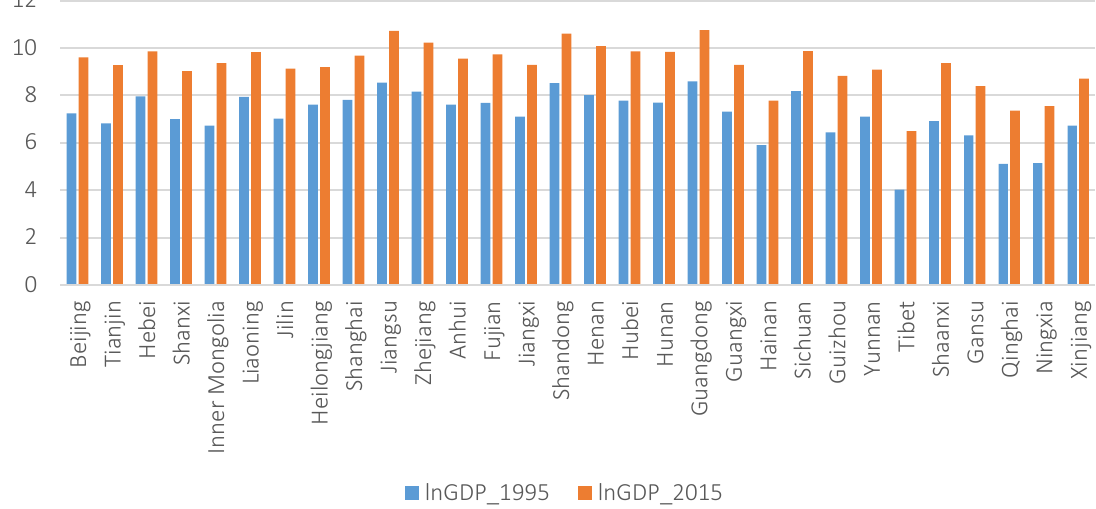
Figure 1. The logarithmic GDP of Chinese regions in 1995 and 2015 (real prices of